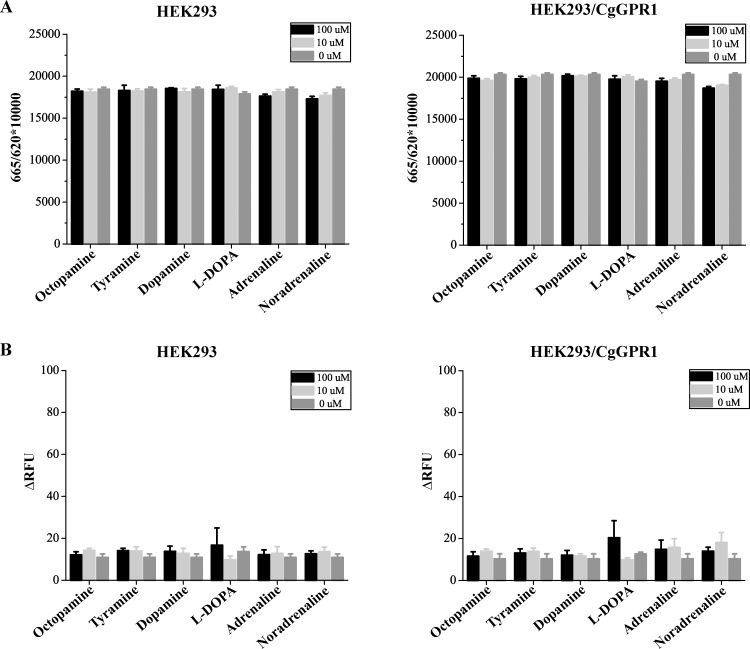
Effects of various biogenic amines on cAMP (A) and Ca2+
(B) levels in HEK293 cells expressing CgGPR1. HEK293 cells with (right panels) or without CgGPR1 (left panels) were treated with indicated biogenic amines at different concentrations. cAMP levels were indicated as the ration between the absorbance of the reaction system at 665 nm and 620 nm. Ca2+ levels were indicated by the fluorescent intensity of the reaction system (ΔRFU). Treated HEK293 cells without CgGPR1 by biogenic amines and untreated HEK293 cells with CgGPR1 was used as negative controls. Compared to the control groups, no significant changes in cAMP (A) and Ca2+ (B) levels were observed in HEK293 cells expressing CgGPR1 upon the addition of octopamine, tyramine and related biogenic amines.